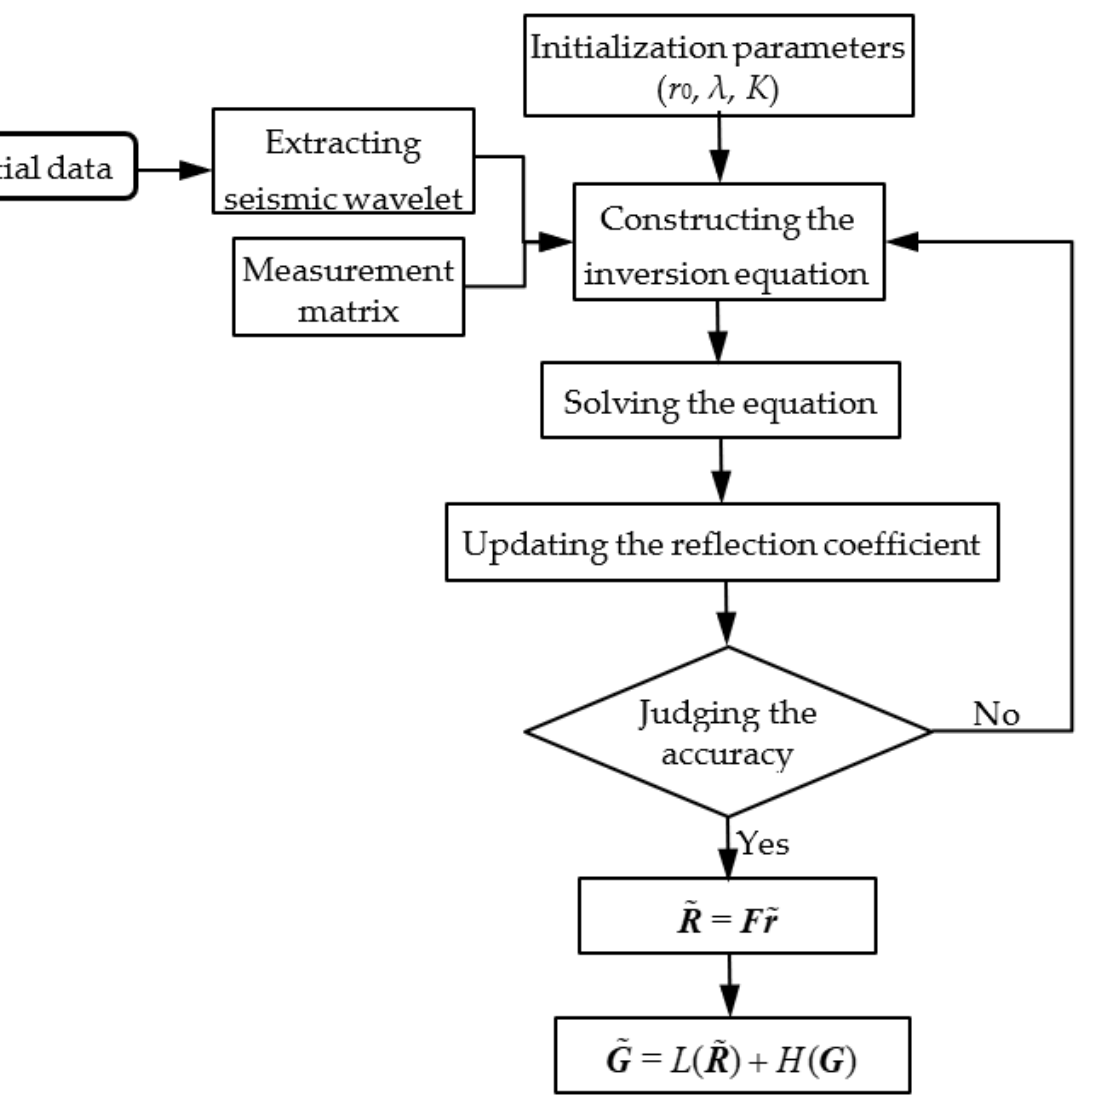
Figure 2. Low-frequency expansion process based on CS [21].